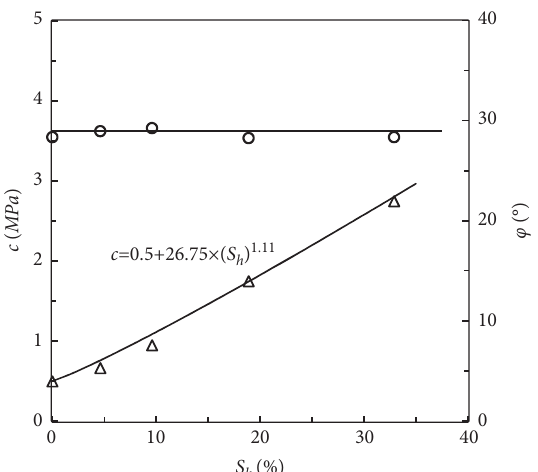
Figure 9: The cohesion and internal friction angle versus hydrate saturation for